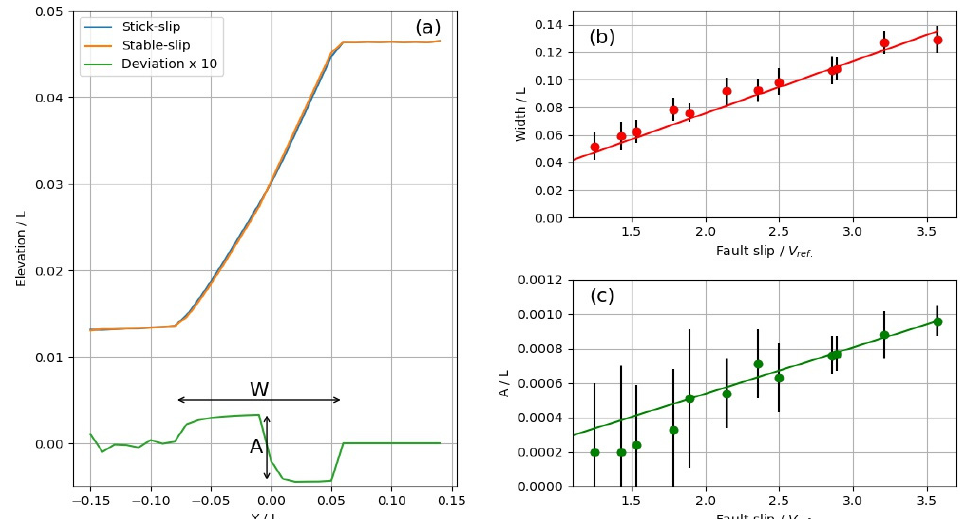
19 of 24 Figure 11. Morphological signature of fault slip rate. ( a ) Elevation associated with stick-slip behavior assuming the fault